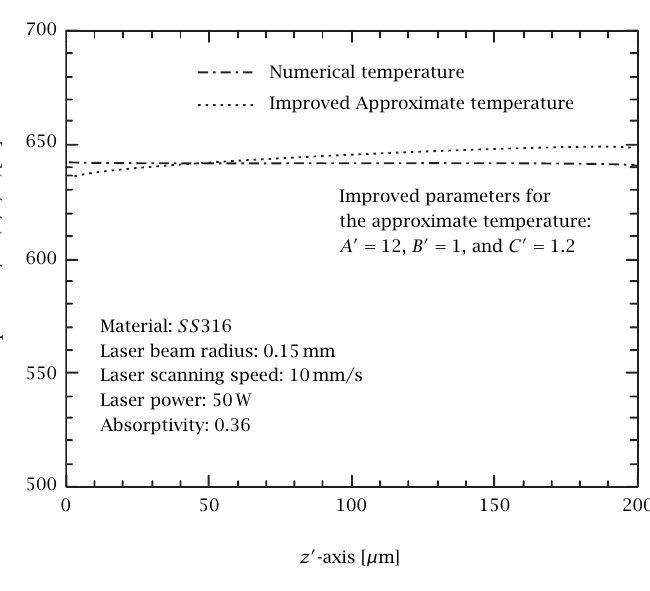
Figure 2.6 . Comparison between the numerical and improved approximate temperatures ( r = 0 . 45mm